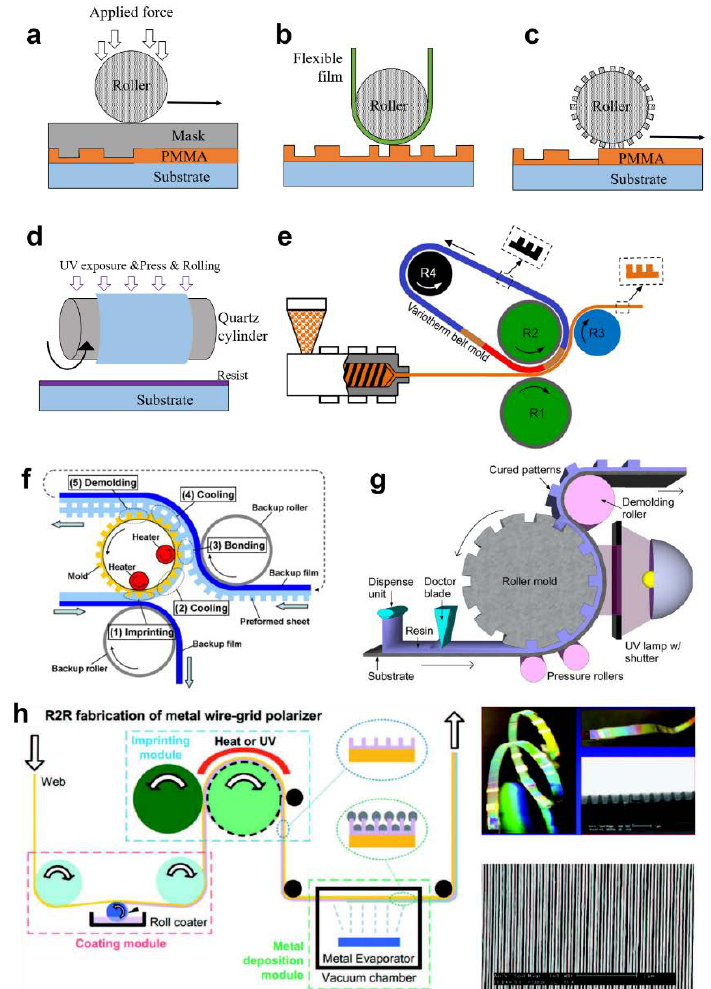
Figure 8. Schematics of roller-based NIL. ( a ) Roll to plate (R2P) NIL using a flat mold with a roller press. ( b ) Thermal R2P NIL systems using a flexible polymer film. ( c ) Thermal R2P concept with pattern stamper. ( d ) UV R2P NIL using a flexible mold. ( e ) Thermal R2R process with a variotherm